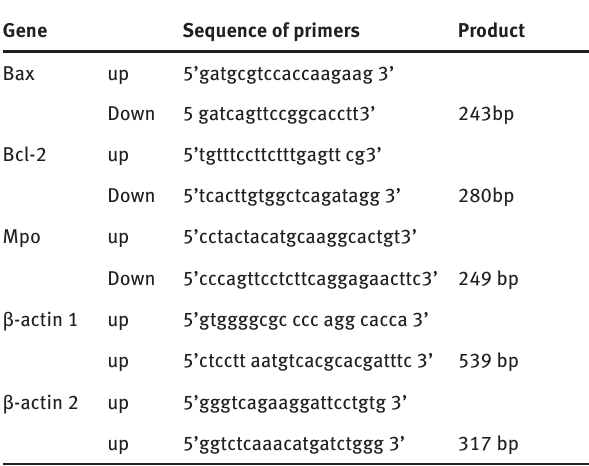
Table 1: Primers for the RT-PCR experiments performed in this study